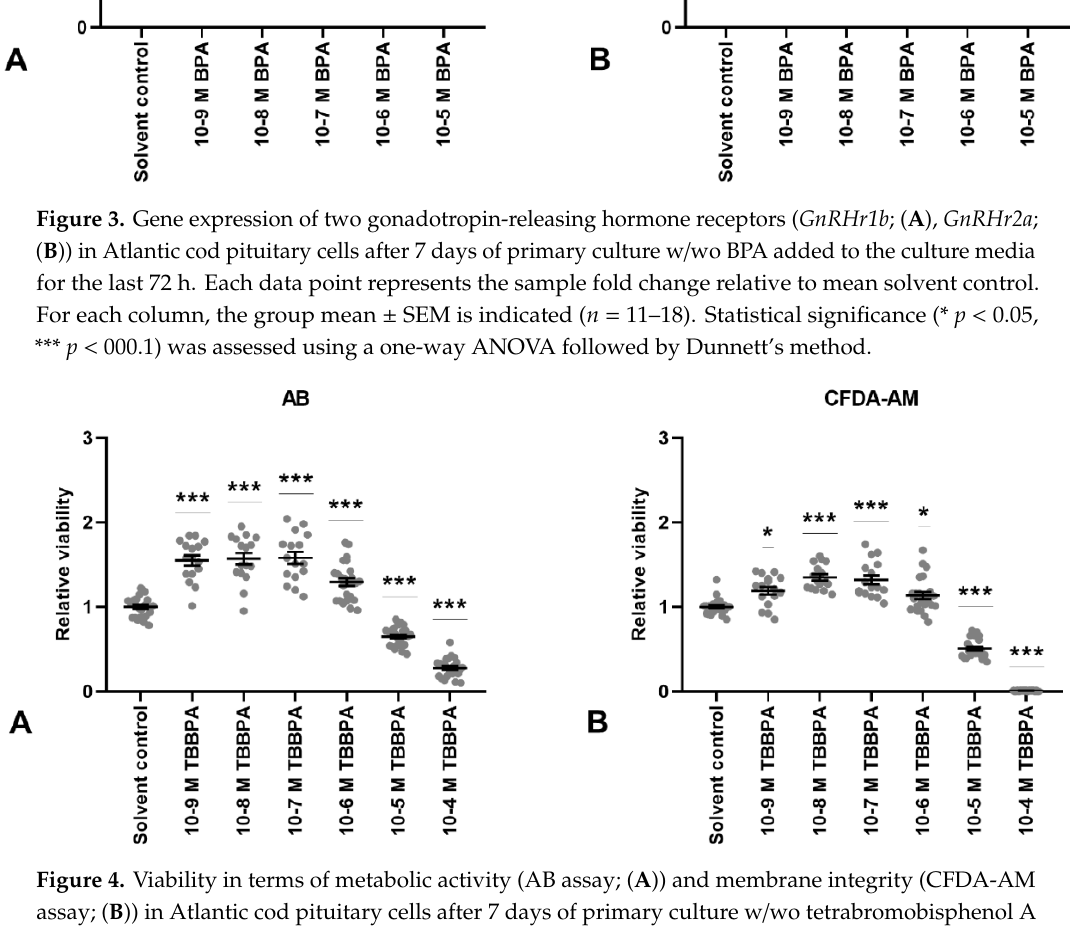
Figure 5. Gene expression of gonadotropin subunits ( FSHb ; ( A ), LHb ; ( B )) in Atlantic cod pituitary cells after 7 days of primary culture w/wo TBBPA added to the culture media for the last 72 h. Each data point represents the sample fold change relative to mean solvent control. For each column, the group mean ± SEM is indicated ( n = 11 – 12). Statistical significance (* p < 0.05) was assessed using the Kruskal – Wallis test followed by the Steel method. Gene expression levels of both GnRH receptors ( GnRHr1b and grnrh2a ; Figure 6A,B, respectively) was unaffected by TBBPA concentrations of 10 − 9 M to 10 − 6 M, but decreased significantly after 10 − 5 M TBBPA treatment. In terms of gene expression, TBBPA exposed samples displayed larger in-group variation than BPA exposed samples.